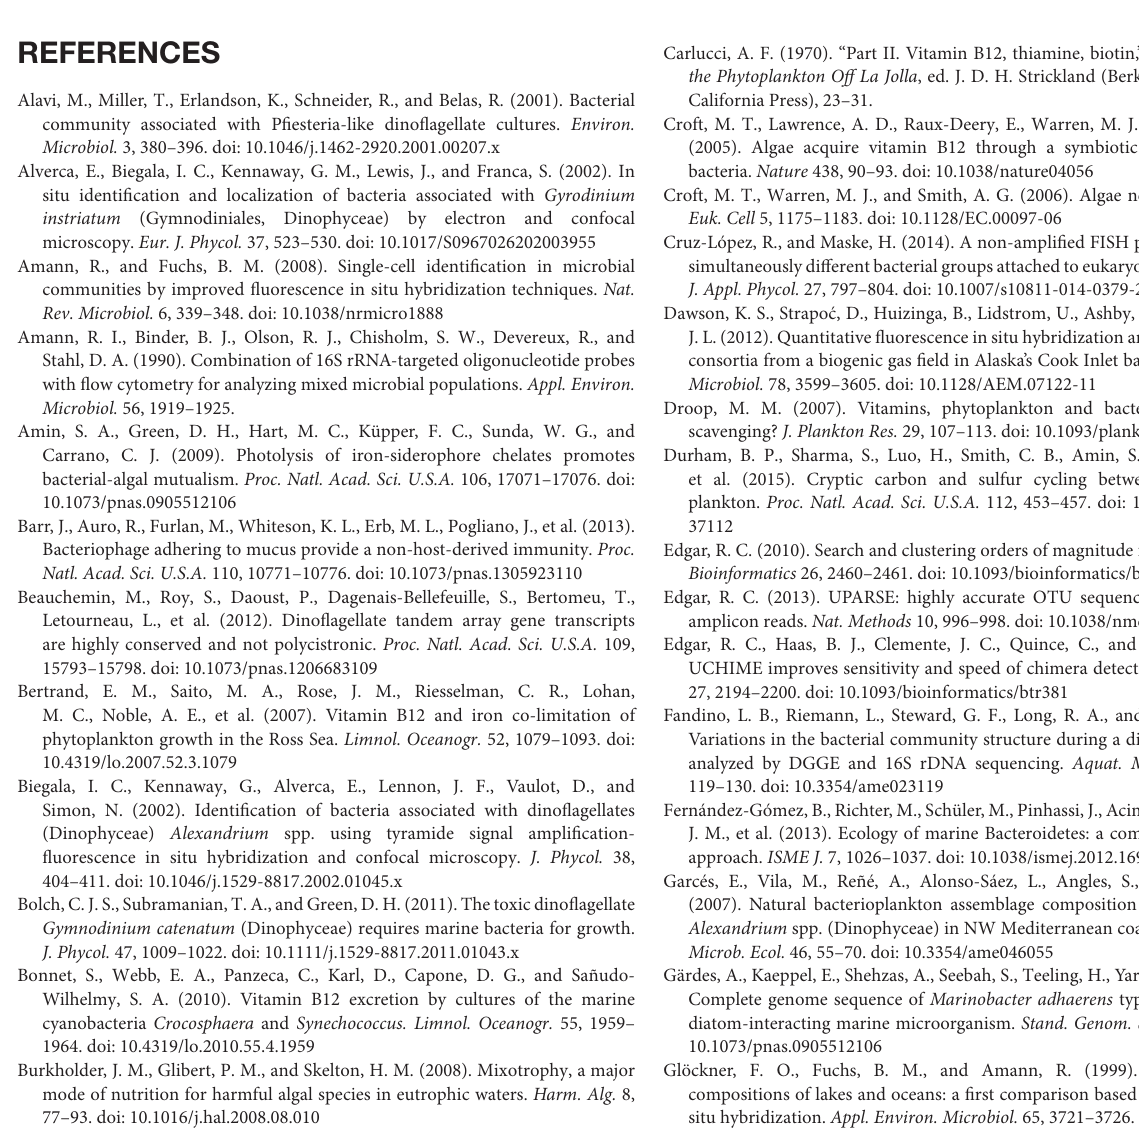
FIGURE S1 | Growth of L. polyedrum and associated bacteria culture under B-s